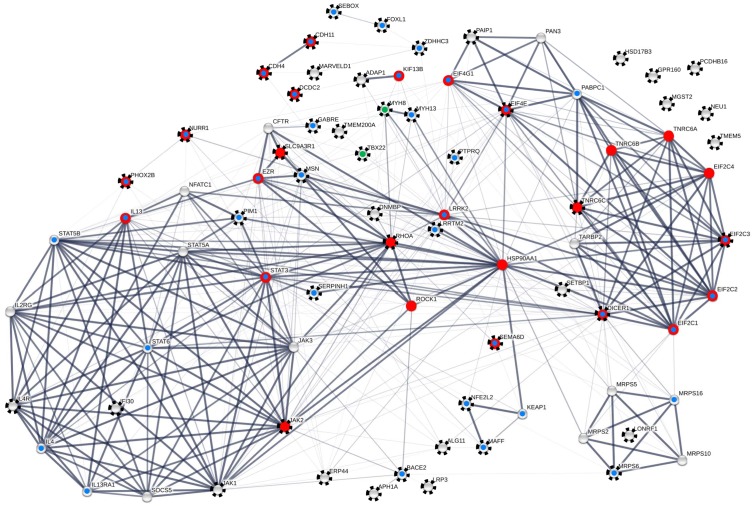
FOXP2-driven protein–protein interaction (PPI) network including 80 proteins. Seventy-four nodes are contained in the largest connected component (LCC). Black rays highlight 49 proteins with empirical evidence for FOXP2/Foxp2-driven and/or songbird-song-related expression regulation from the present and previous analyses (see Tables 2, 3 as well as Supplementary Tables 2.1, 2.4 for details). Red dots highlight proteins that matched with neuron-related GO terms in enrichment analysis (see Supplementary Table 2.8). Blue dots indicate nodes whose implication in neuronal and neural functions and/or diseases and disorders is detailed in the Discussion. This is a conservative estimate as exemplified by ERP44 which might have neural relevance (see Discussion) but is not categorized as such in this scheme. Green dots refer to an involvement in trismus-pseudocamptodactyly (MYH8) and X-linked cleft palate and ankyloglossia (TBX22). Proteins in the LCC have 11.342 direct interactors (node degree) on average. Thickness of edges correlates with confidence scores ≥0.90, ≥0.7, ≥0.4, and ≥0.15. The clustering coefficient varied between 0.616 and 0.831 depending on the confidence threshold applied. The network was constructed with the aid of STRING v. 10.0 and analyzed with the aid of Cytoscape v. 3.2.1 and the NetworkAnalyzer plugin. For individual node degrees and additional network statistics see Supplementary Tables 2.6, 2.7.